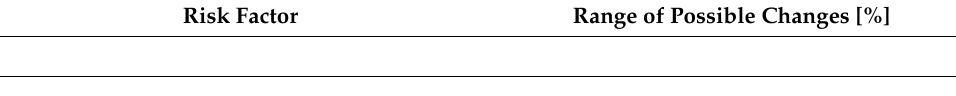
Table 7. Risk factors and the scope of their changes. Source: designed by authors. Risk Factor Range of Possible Changes